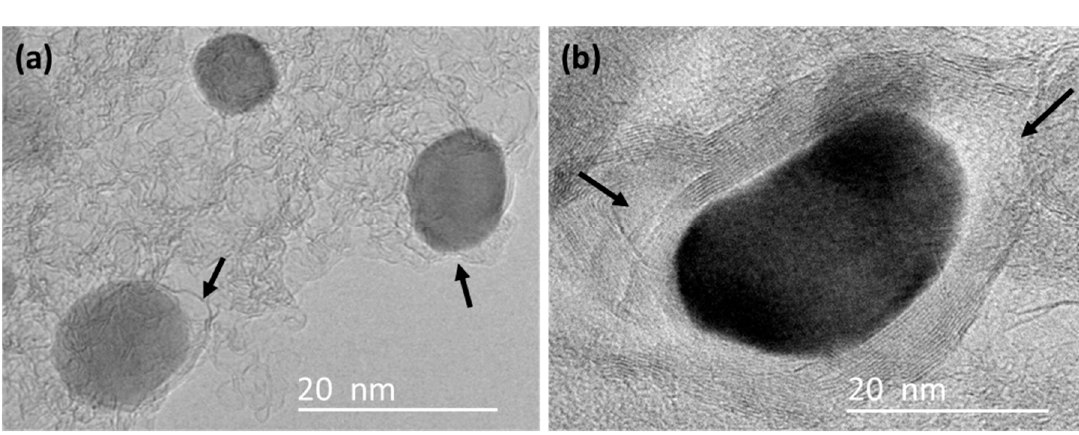
Figure 7. TEM images of ( a ) thin-walled GCEINs and ( b ) thick-walled GCEINs in sample KL/Fe-800. The structural defects in the graphitic-carbon shells are indicated by arrows.